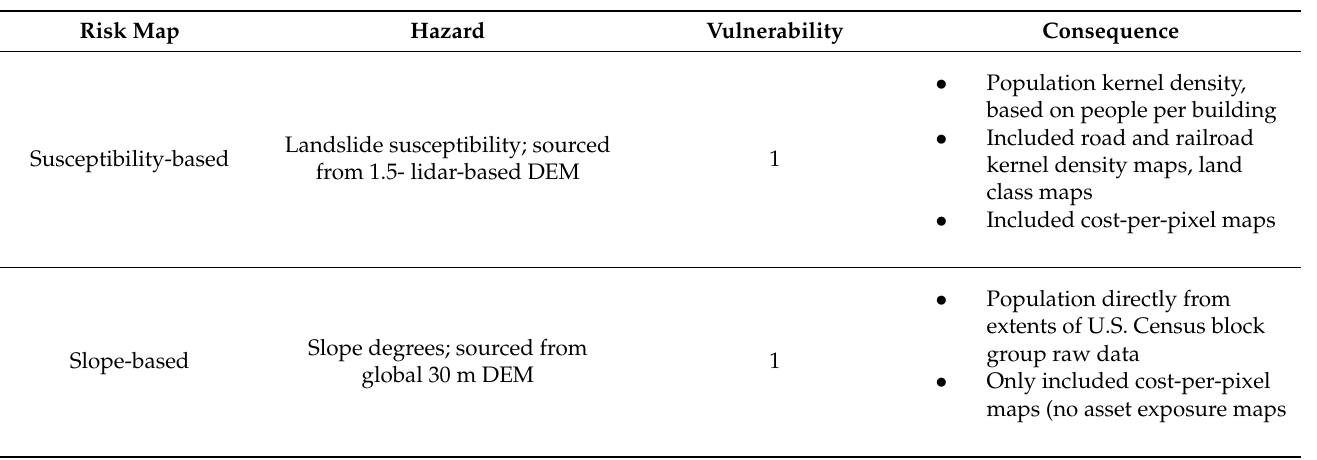
Table 5. Risk modelling differences between the landslide susceptibility hazard input approach and the slope-based hazard input approach. Road, railroad, and land cost-per-pixel maps remained the